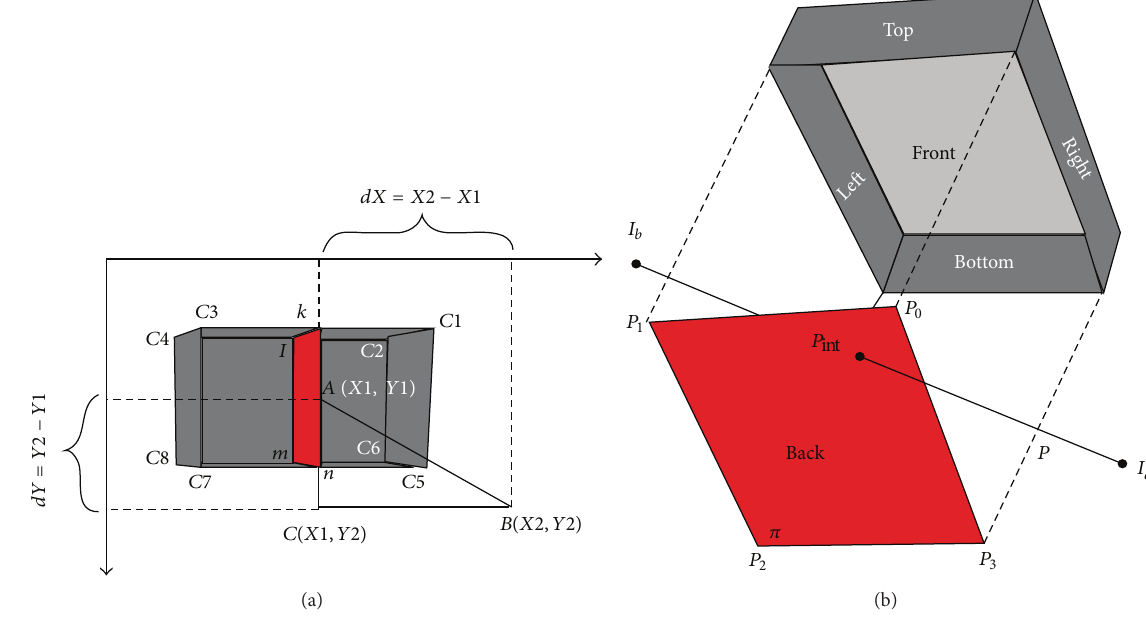
Figure 6: (a) Distance calculation between ray source and EAS. (b) Intersection point calculation between ray and a surface.